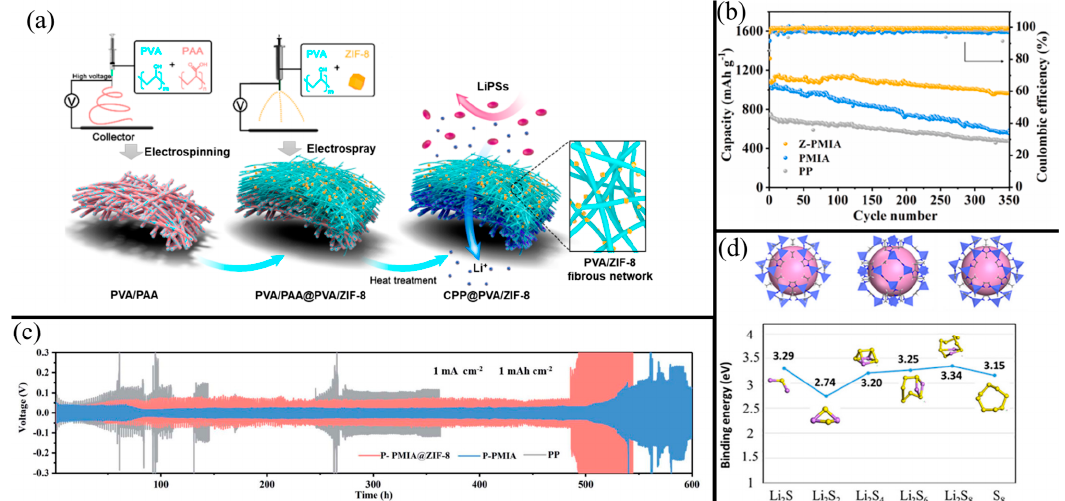
Figure 8. ( a ) Schematic diagram illustrating the fabrication of cross-linked PVA/PAA modified with ZIF-8 MOF. Reprinted/adapted with permission from Ref. [131]. (Copyright 2021, American Chemical Society). ( b ) The capacity retention of an LSB with a PP, PMIA NF, and ZIF-modified PMIA NF separators. Reprinted/adapted with permission from Ref. [73]. (Copyright 2021, Elsevier). ( c ) Li plating/stripping performance in symmetric Li cells with PP, PVDF-HFP/PMIA, and ZIF-8-modified PVDF-HFP/PMIA separators. Reprinted/adapted with permission from Ref. [21]. (Copyright 2022, Royal Society of Chemistry). ( d ) DFT skeletons of ZIF-67 surrounding a substrate from 3 orthogonal viewpoints and the binding energy of various LiPSs and S 8 to the MOF as a substrate in the MOF cavity. Reprinted/adapted with permission from Ref. [117]. (Copyright 2020, Elsevier).